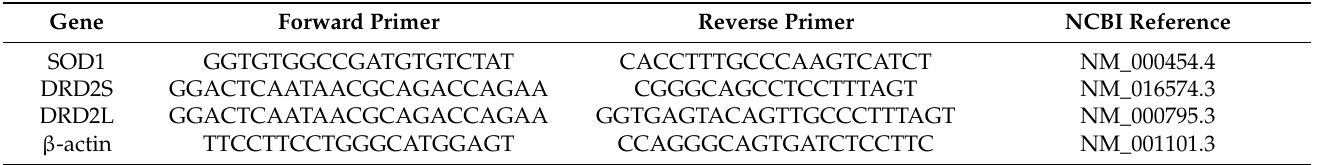
Table 1. List of primer sequences and NCBI reference sequences identifying primer pairs a